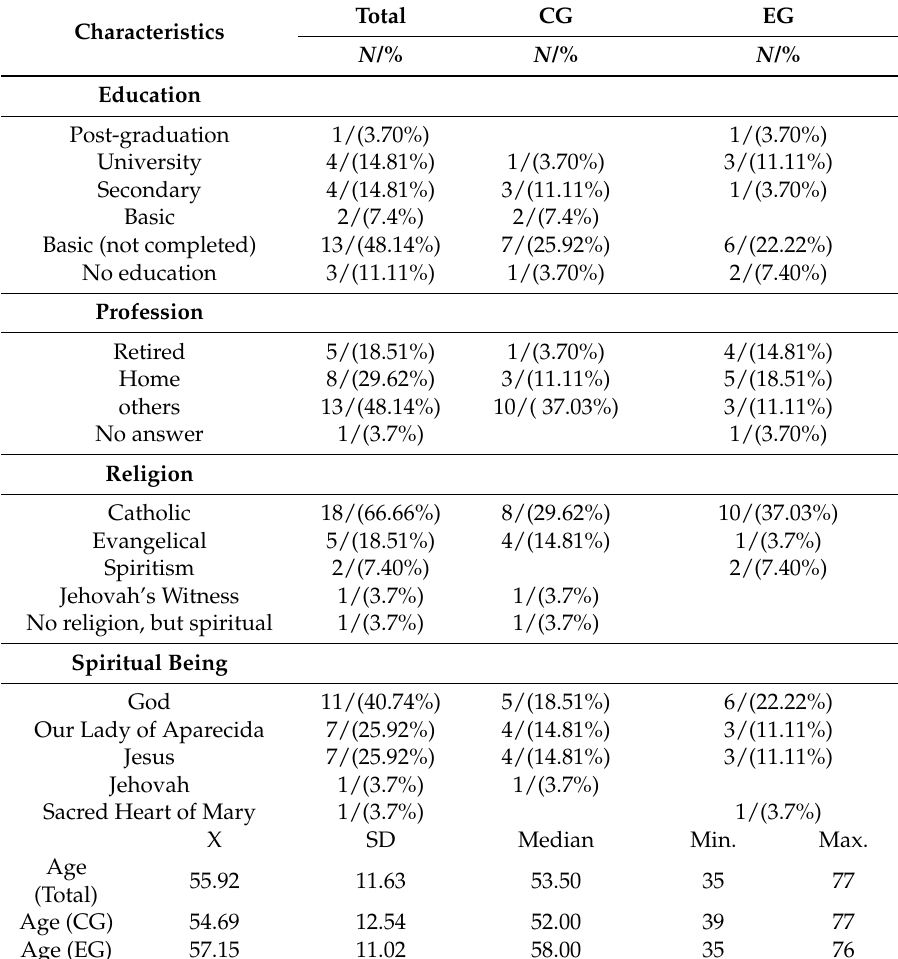
Table 1. Demographic